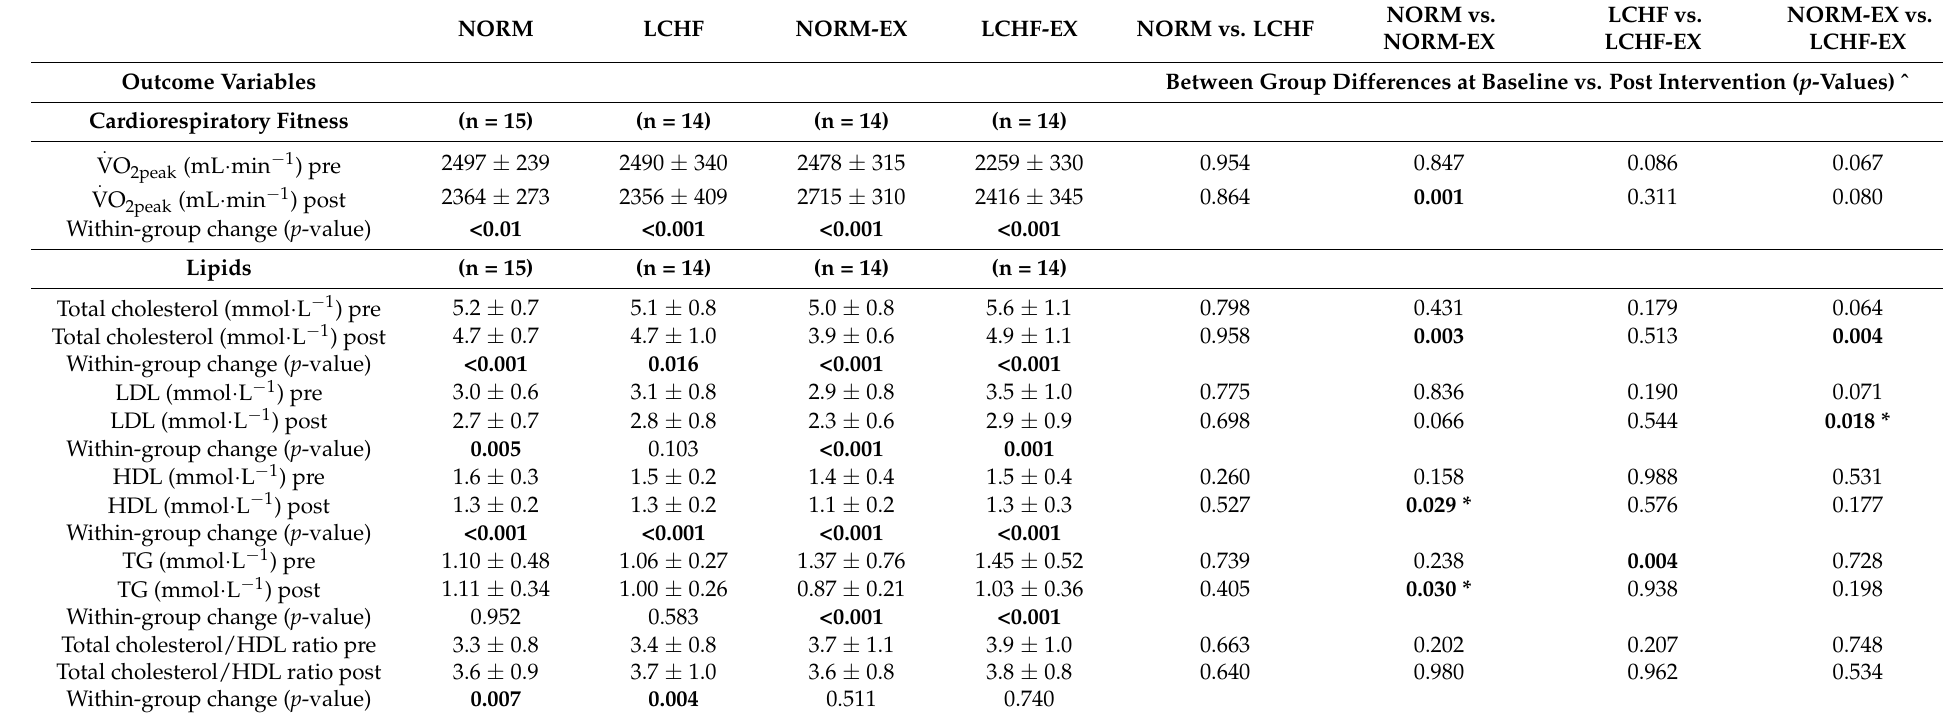
Table 3. Cardiorespiratory fitness and lipid profile at baseline and after the 10-week intervention. NORM LCHF NORM-EX LCHF-EX NORM vs. LCHF